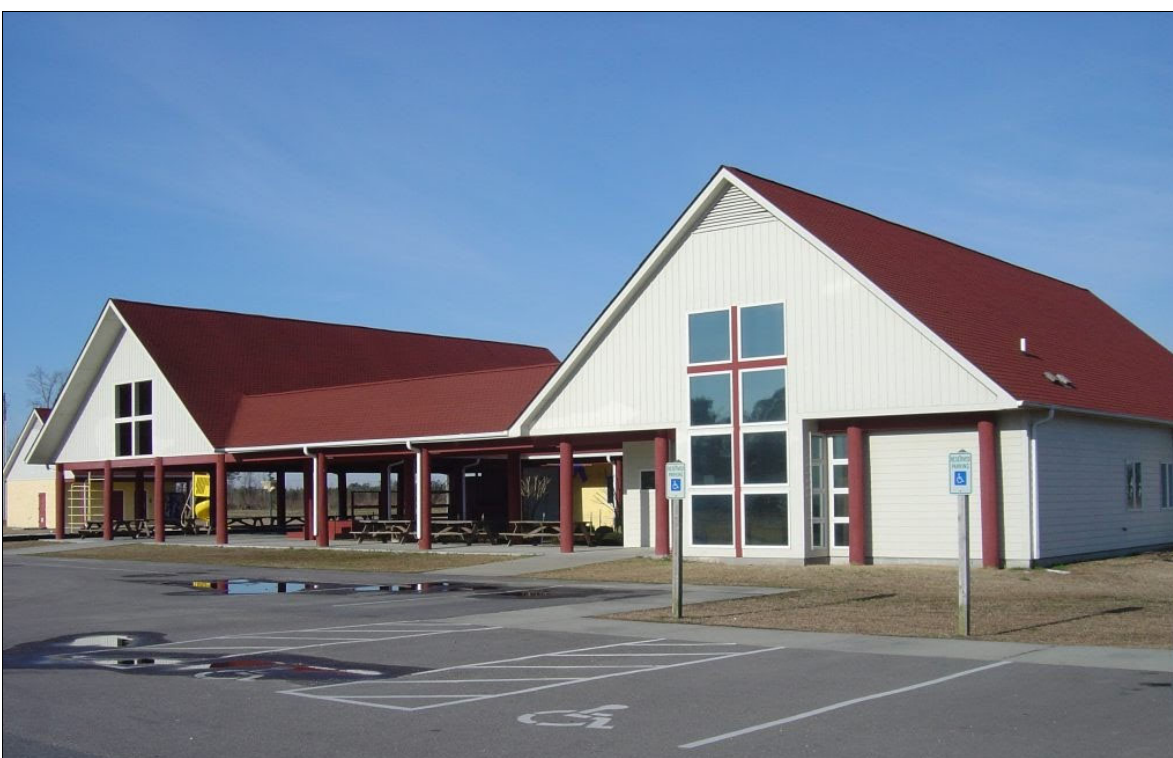
Figure 1. The Episcopal Farmworker Ministry (EFWM) Facility in Dunn, North Carolina